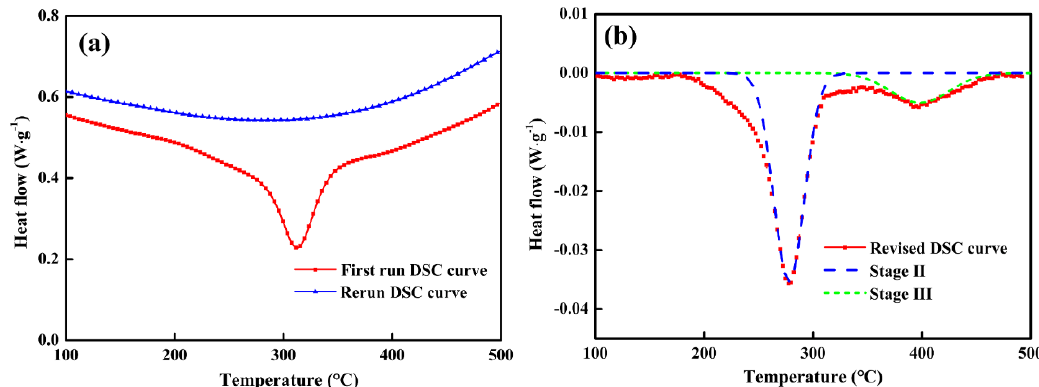
Figure 2. ( a ) The differential scanning calorimetry (DSC) curves at heating rate of 5 °C/min; ( b ) revised DSC curves after subtracting baseline.